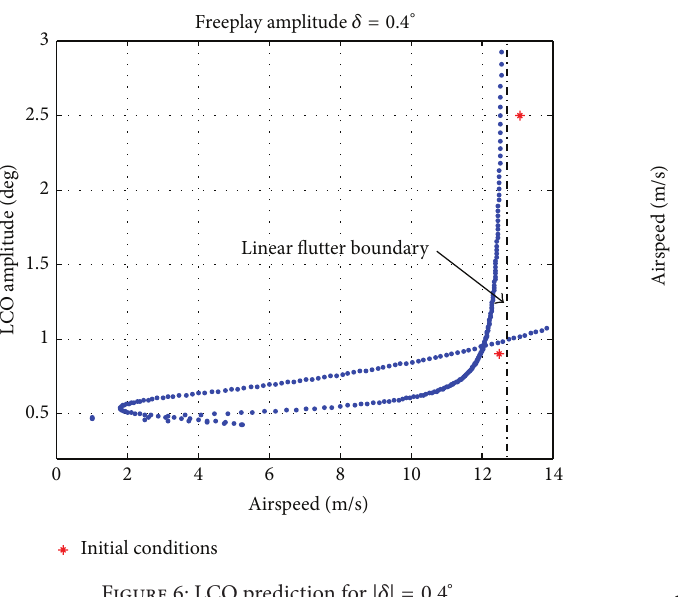
Figure 6: LCO prediction for |𝛿| = 0.4 ∘ .